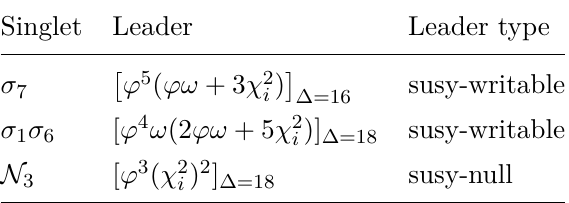
Table 6 . Scalar leaders with N φ = 7 , N der = 0 in d = 8